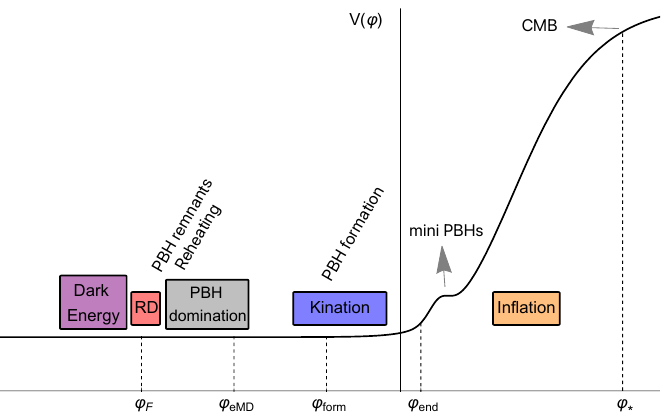
Figure 10. A schematic illustration of the runaway inflationary model and the cosmic phases realized with respect to the inflaton field